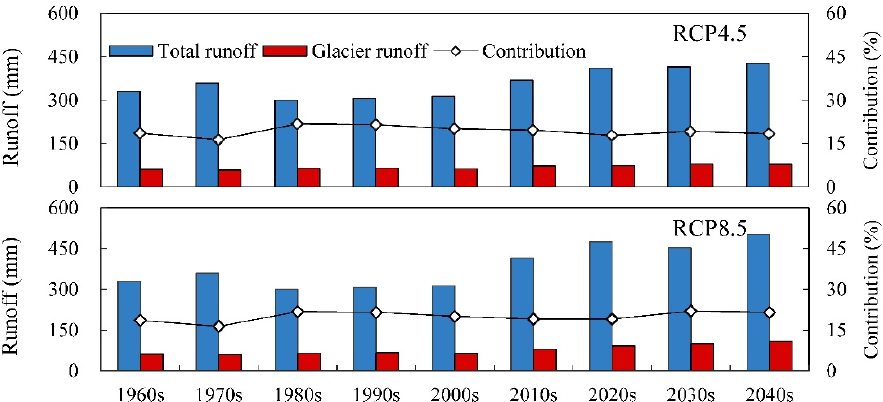
Figure 9. Projected changes in the total runoff, glacier runoff, and the contribution of glacier run-